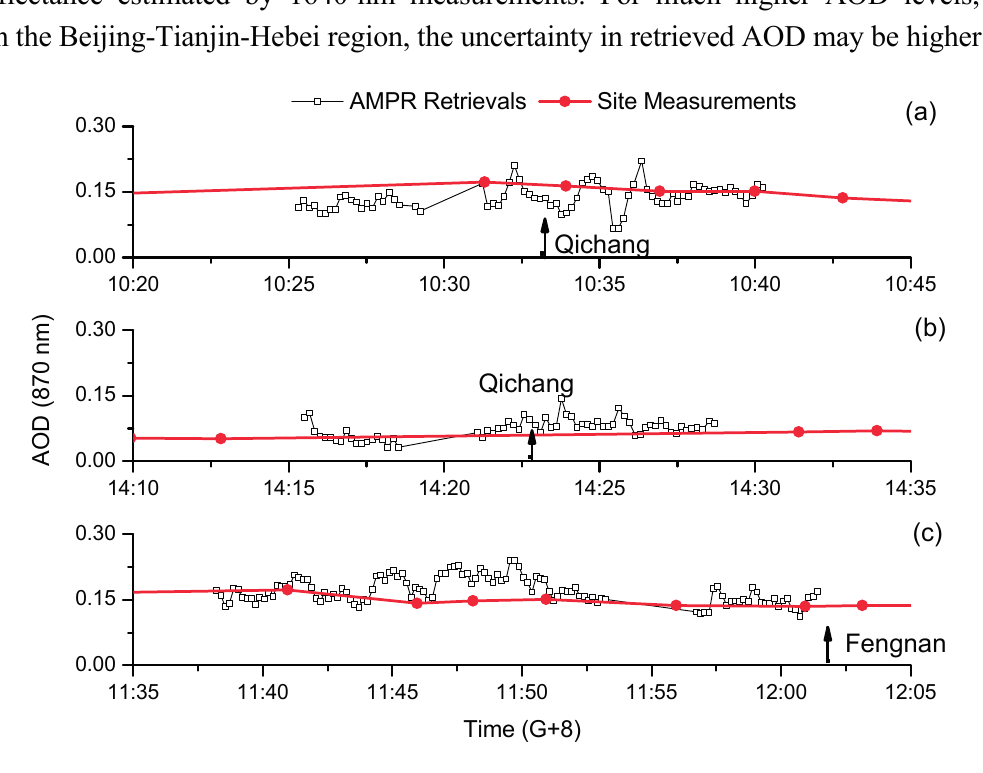
Figure 6. AMPR retrievals (AOD at 865 nm) compared with Sun-sky radiometer measurements at Qichang and Fengnan sites. ( a ) Flight 1; ( b ) Flight 2; ( c ) Flight 3. Table 4. List of ground-based measurements and AMPR retrievals of AOD for comparison.